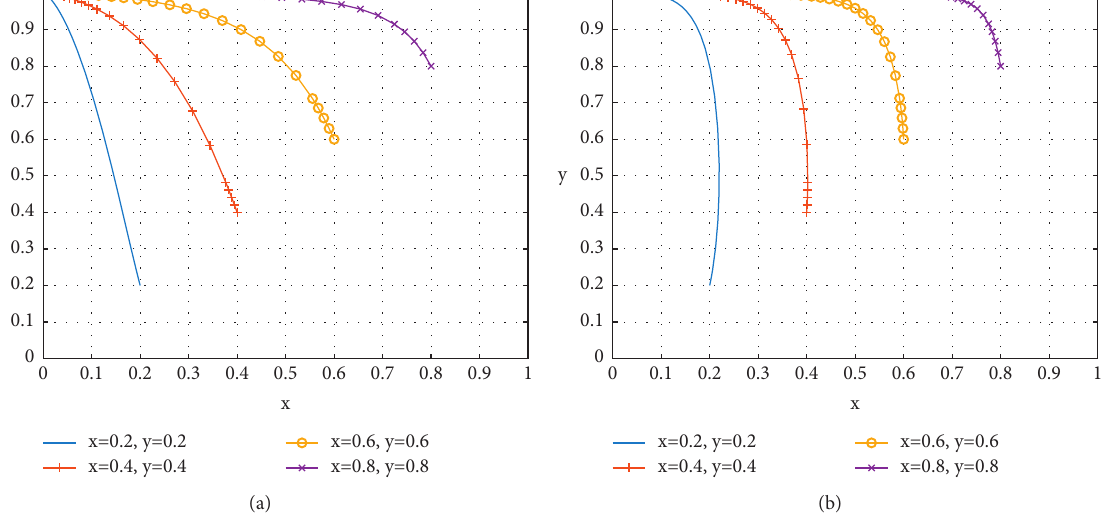
Figure 3: Simulation results of Case 3.